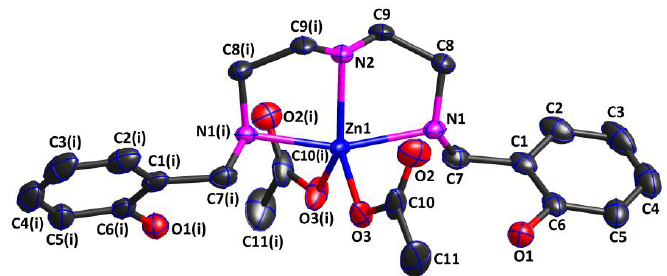
Figure 3. Crystal structure of Complex 2 , showing the 30% probability level of thermal ellipsoids (all H atoms are omitted for clarity). Symmetry code: (i) 1 − x,y,1/2 − z.